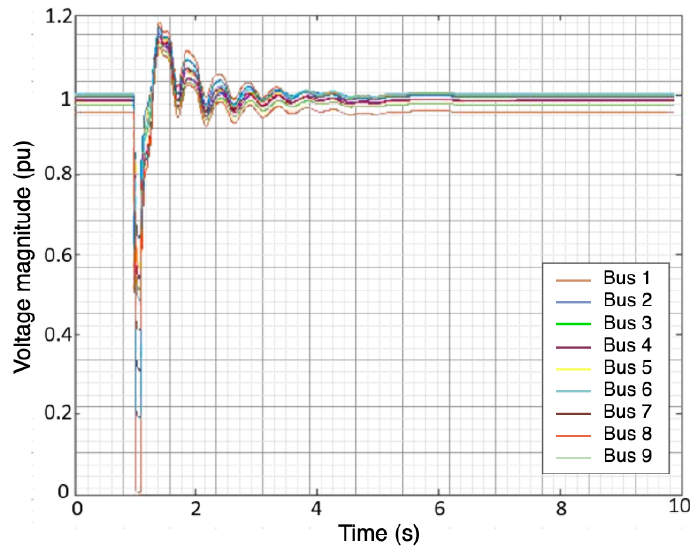
Figure 2. Voltage magnitude of the 9 buses after injecting three—phase fault. Table 2. Common three-phase fault modeling for nine scenarios with different duration.